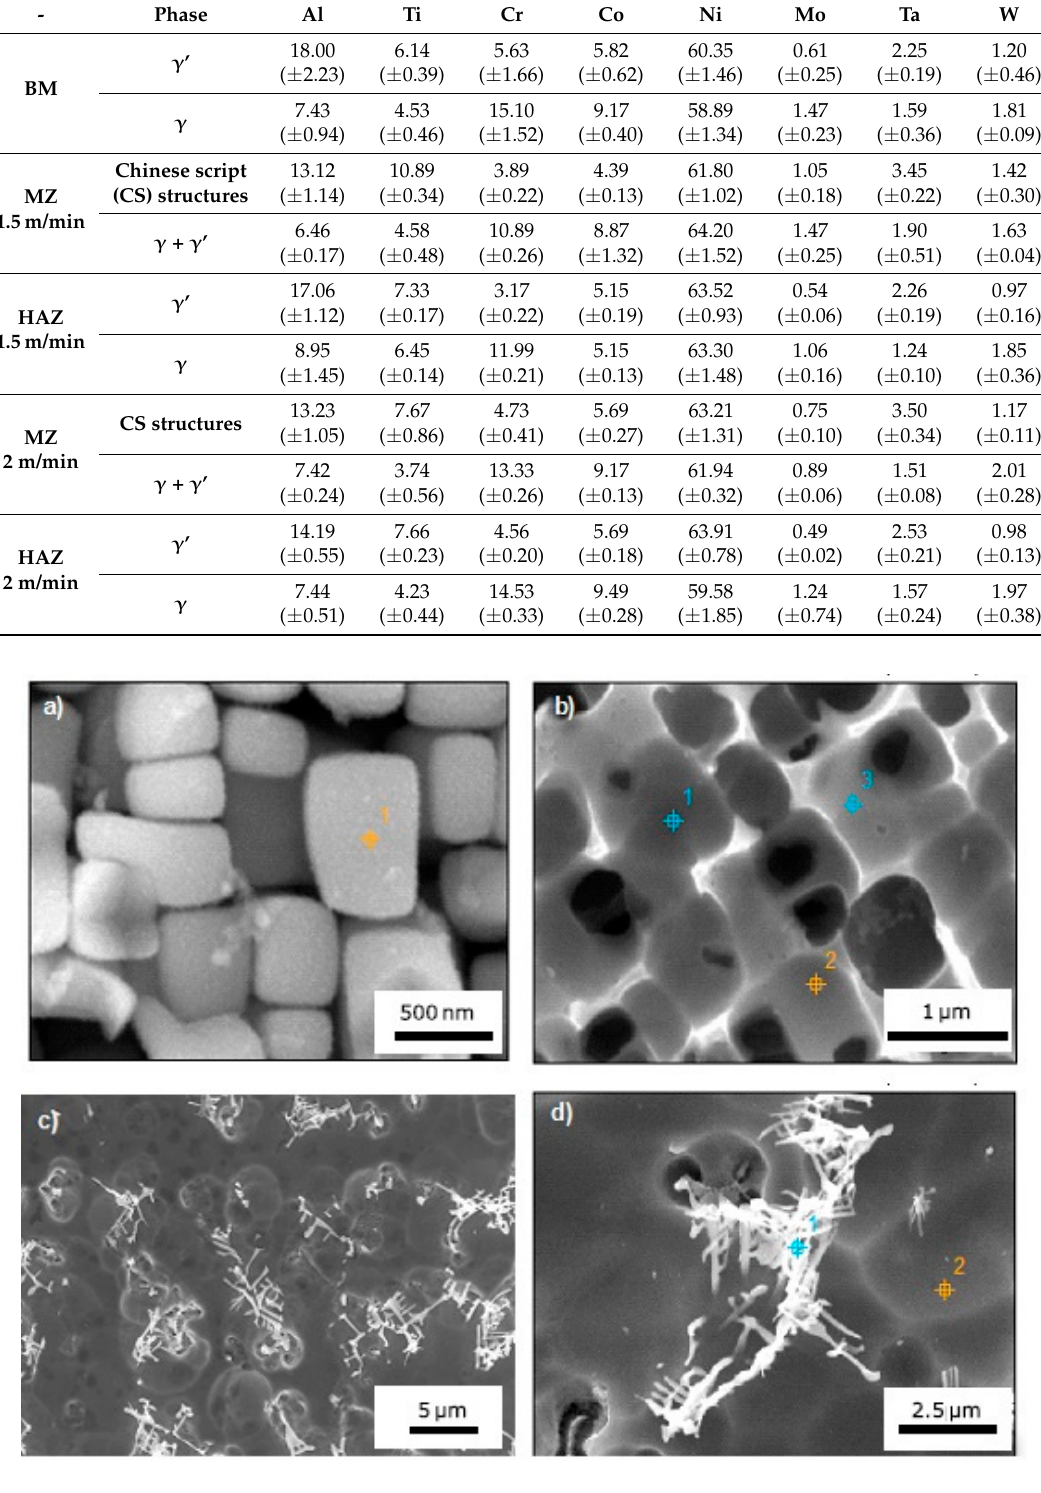
Figure 11. EDS measurements on welds with PHT = 300 °C, pass speed of 1.5 m/min and PWHT = 750 °C: single γ ’ particles ( a ); γ phase ( b ) in HAZ; Chinese script structures inside the MZ ( c , d ).